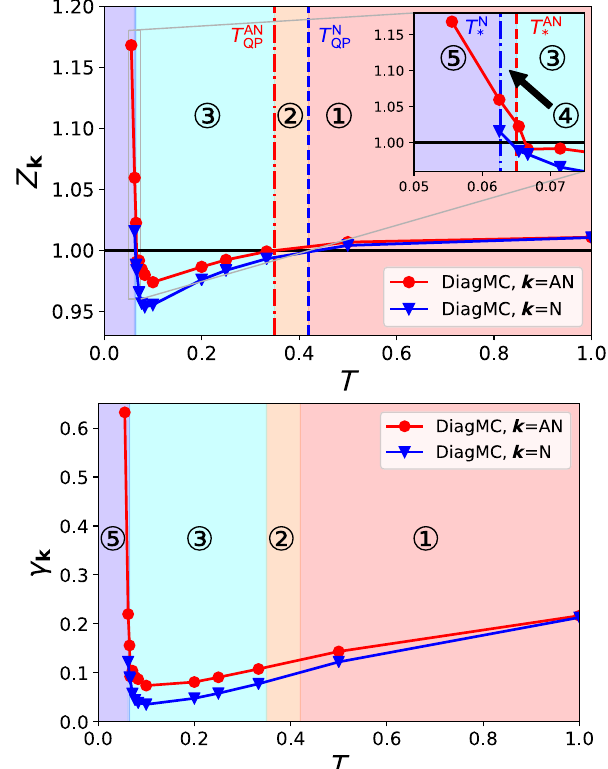
FIG. 19. Quasiparticle parameters Z k (upper panel; the gray box denotes the boundaries of the inset) and γ k (lower panel) at the antinode (red circles) and node (blue triangles) for the DiagMC benchmark as a function of